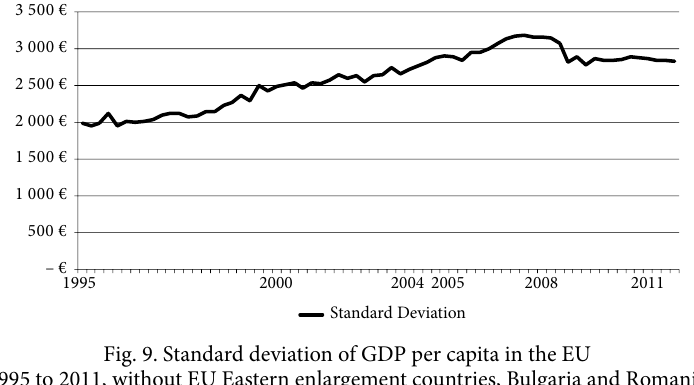
Fig. 9. Standard deviation of GDP per capita in the EU (1995 to 2011, without EU Eastern enlargement countries, Bulgaria and Romania) Source : own